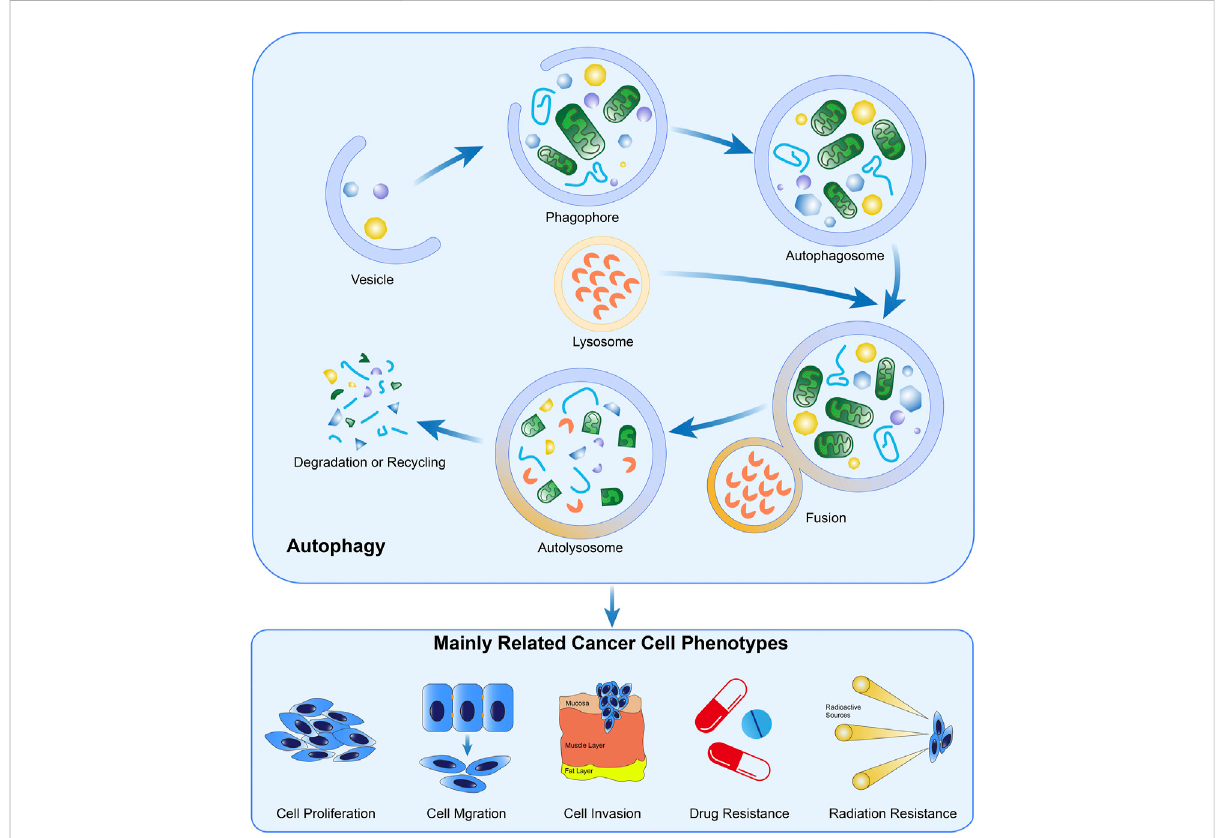
FIGURE 2 Formation and the biological functions of autophagy in cancer. The crucial steps in the formation of autophagy include autophagosome generation, the fusion of lysosomes and autophagosomes, and material degradation in autolysosomes. Evidence demonstrated autophagy is widely involved in the biological processes of cancer